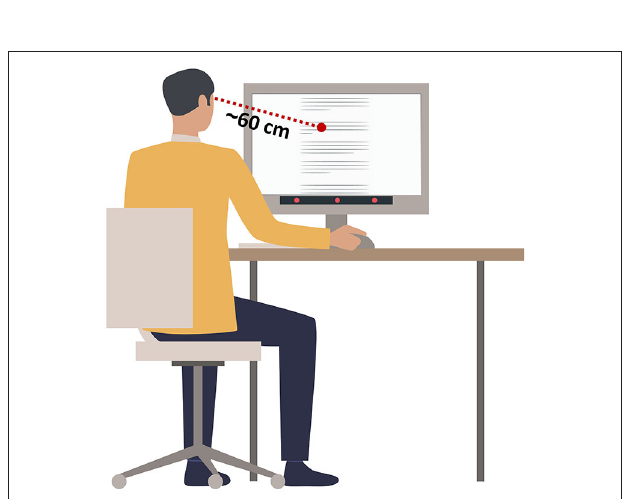
FIGURE 3 | Setup of our user study: A user is seated approximately 60 cm from a 27 inch display with the remote eye tracker mounted at its lower bezel.